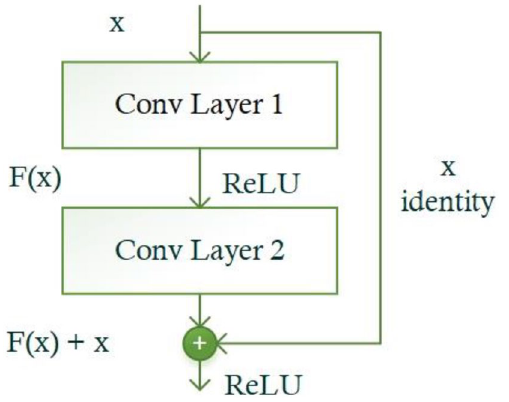
Figure 5. The architectural representation of the basic building block ‘Residual Block’ in